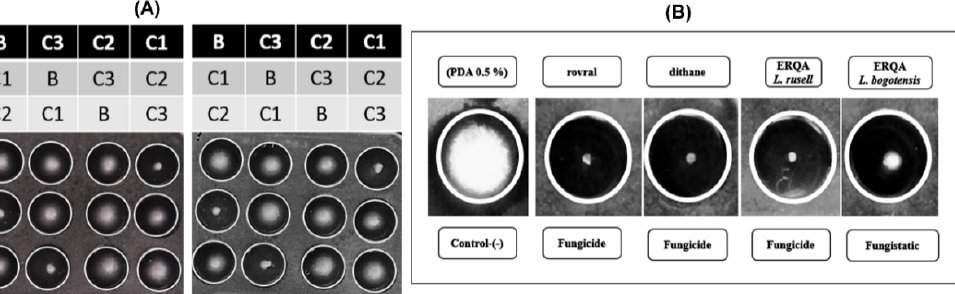
Figure 3. ( A ) Antifungal activity (mycelial growth inhibition) evaluated for the most-active QREs from L. polyphyllus ( left ) and L. bogotensis ( right ) against F. oxysporum . ( B ) (PDA 0.5%), C1 (5 µg/µL), C2 (1 µg/µL), and C3 (0.1 µg/µL). ( B ) Fungicide vs. Fungistatic of the most-active QREs of L. polyphyllus and L. bogotensis.